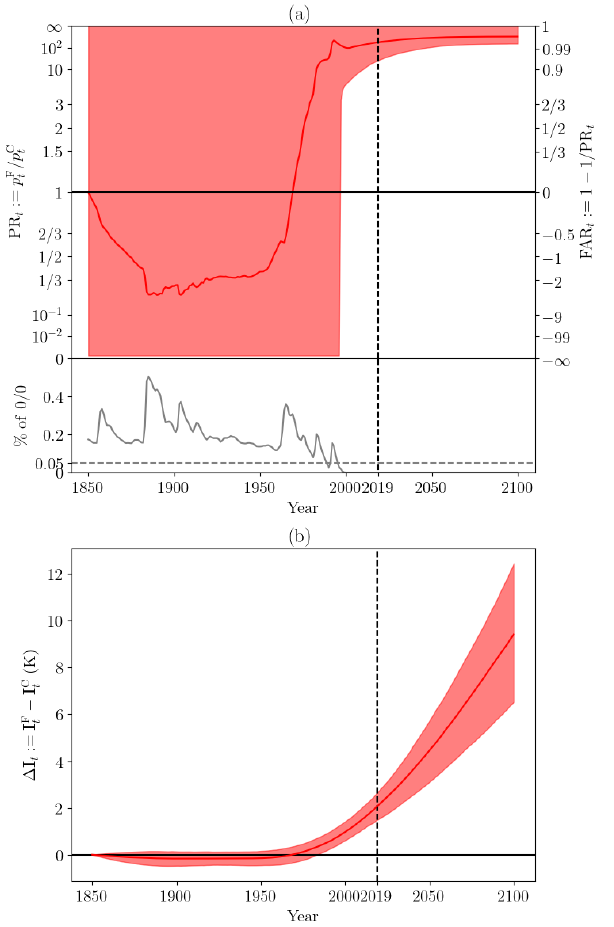
Figure 7. (a) Probability ratio, PR t := p F t /p C t , of multimodel syn- thesis after the Bayesian constraint. The gray line is the proportion of undetermined values (i.e., 0 / 0). If the gray line is larger than 0 . 05 (the dotted gray line), the confidence interval is [ 0 , ∞] . The red shading is the 95% confidence interval of undetermined values ( p F t > 0 or p C t > 0). The red line is the best estimate. (b) Change in intensity (cid:49) I t , i.e., the difference between the value of an event with probability p F in a factual and counterfactual world for each 2019 year. The red shading is the 95% confidence interval, and the red line is the best